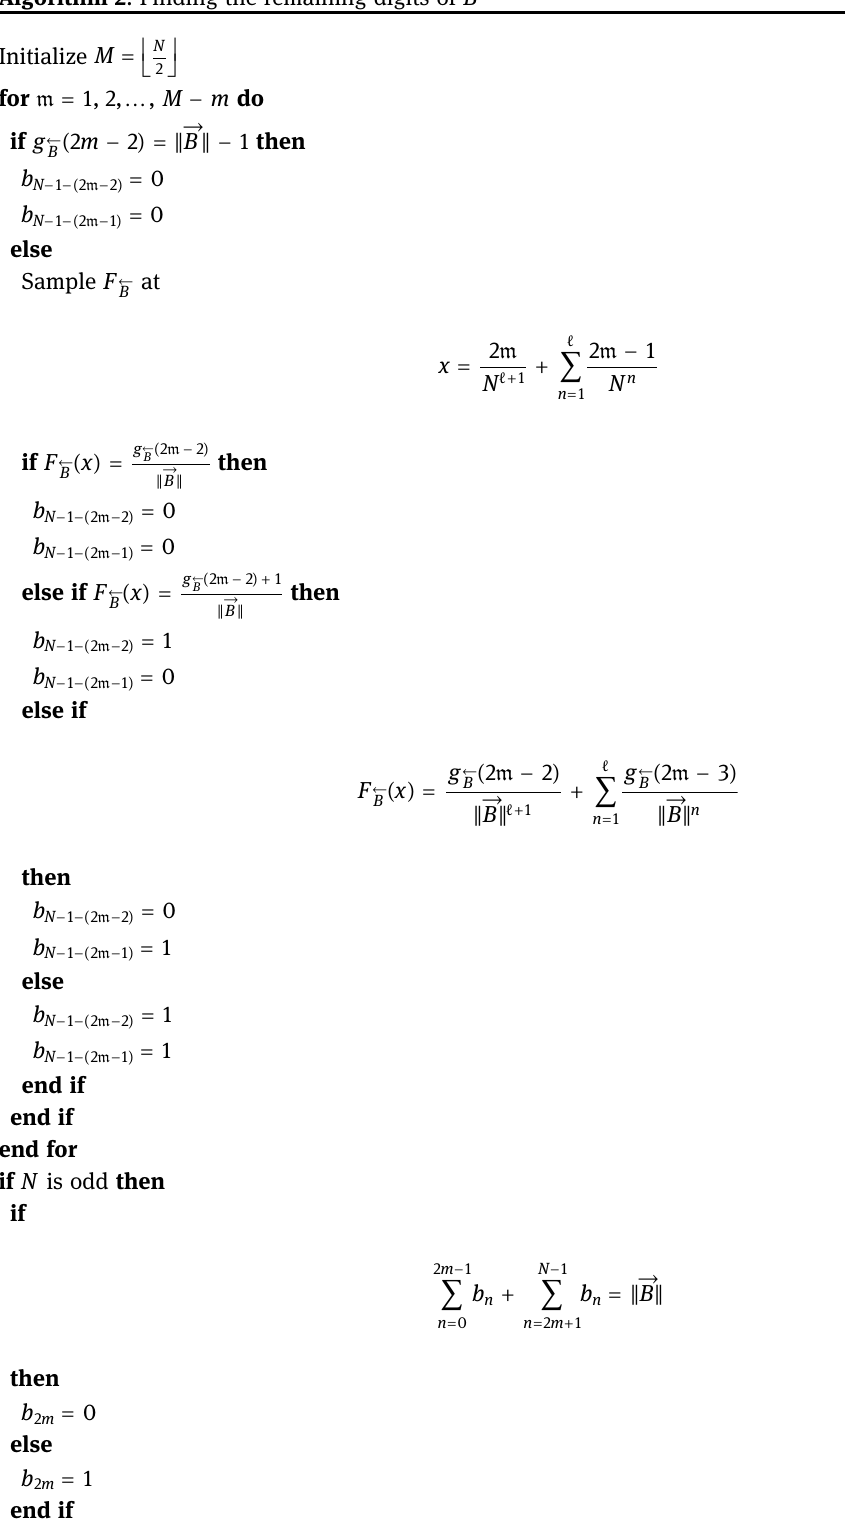
Algorithm 2 . Finding the remaining digits of